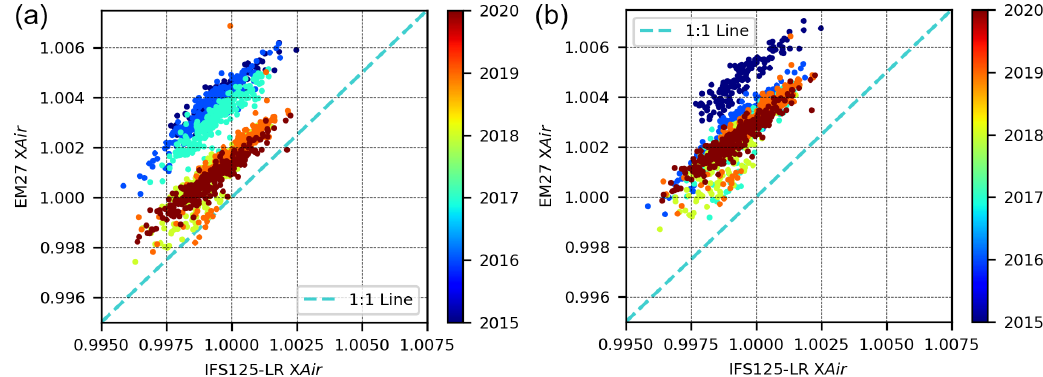
Figure 22. Correlations for the retrieved X AIR by using the instrument SN37 and IFS125-LR. Panel (a) shows the results of the analysis of atmospheric spectra under the assumption of a constant ILS, and (b) shows the results under the assumption of a variable ILS (ILS parameters adjusted on a yearly basis).